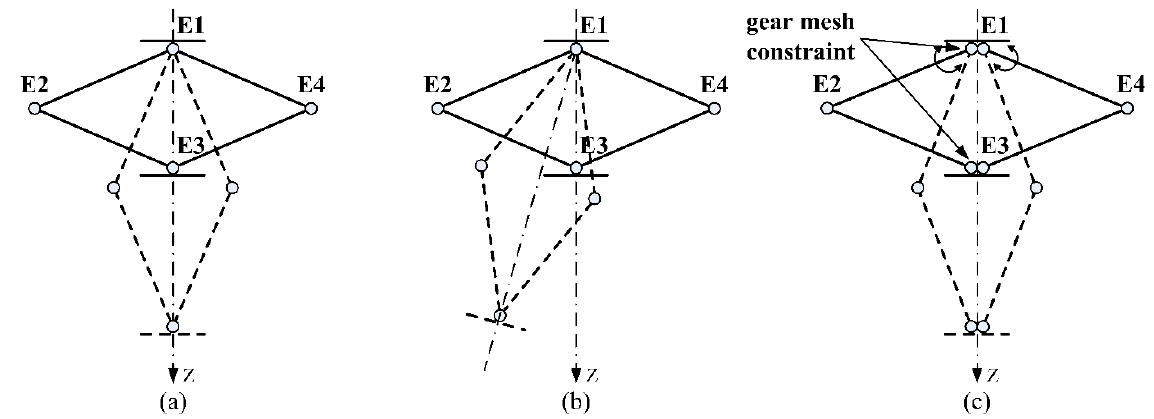
Figure 4. Rhombus linkage. ( a ) A large movement along the Z-axis ; ( b ) Deflection without gear mesh constraint; ( c ) Synchronous motion with gear mesh constraint.